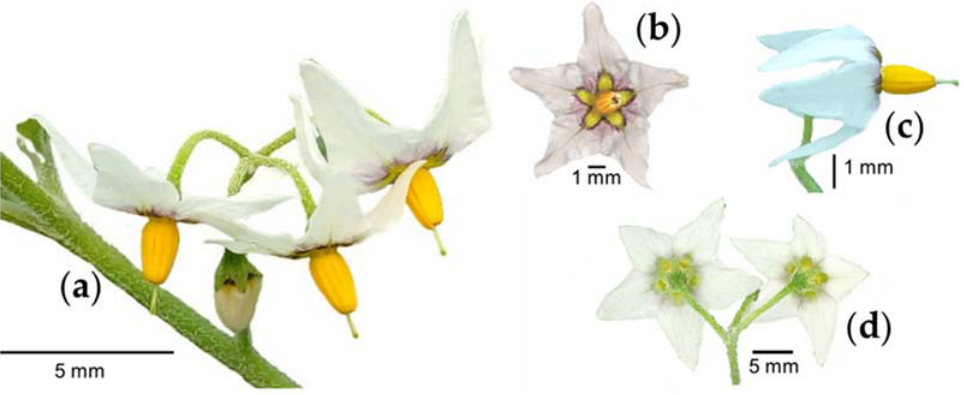
Figure 2. Flowers grouped in racemes ( a ), corolla stellate ( b ), style exserted ( c ), and calyx ( d ) of slender nightshade plant ( Solanum nigrescens ). Photos by Jorge Manuel Valdez-Carrasco ( b ) and Sara Monzerrat Ramírez-Olvera ( a , c , d ).